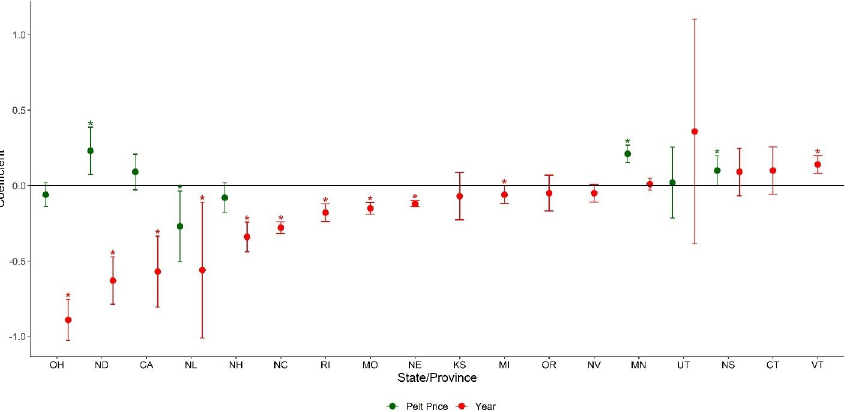
continuous data were available between 1919 and 2017 (see methods section). Markers represent beta estimates and 95% confidence intervals of year and current-year pelt price from linear regression models. Asterisks indicate significant positive and negative effects on harvest. See Table 1 for state/province